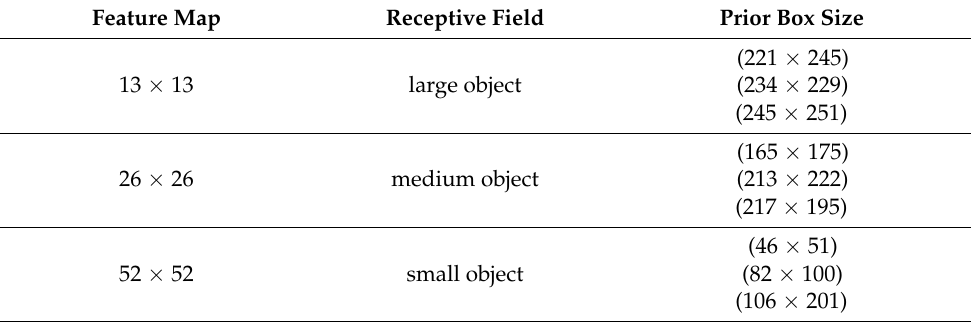
Table 1. The size of the prior box.